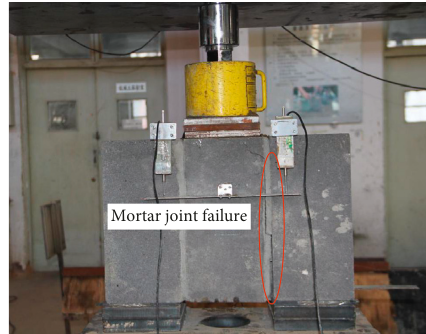
Figure 9: Mortar joint failure.